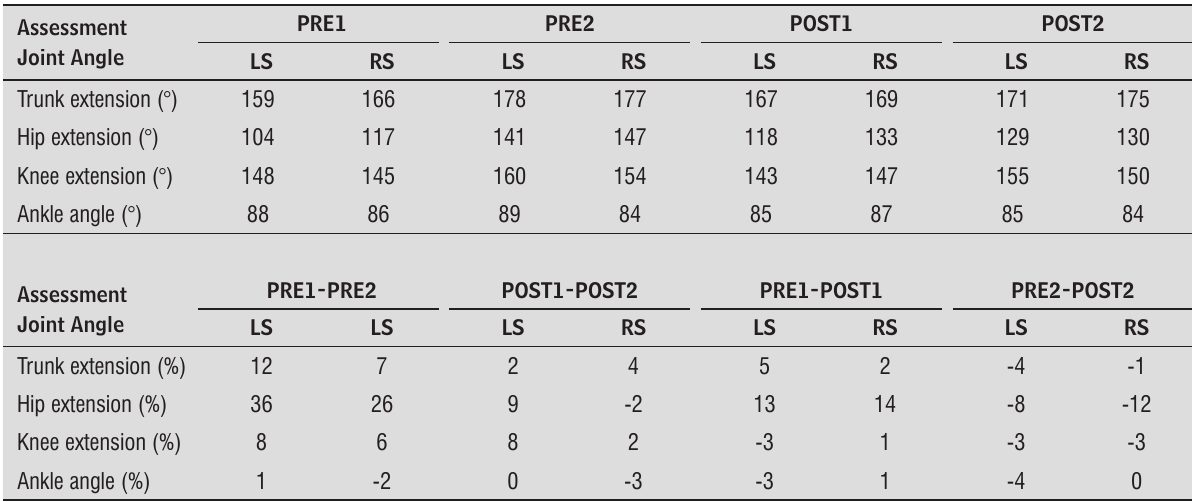
Table 1 - Data for postural assessment (in degrees and